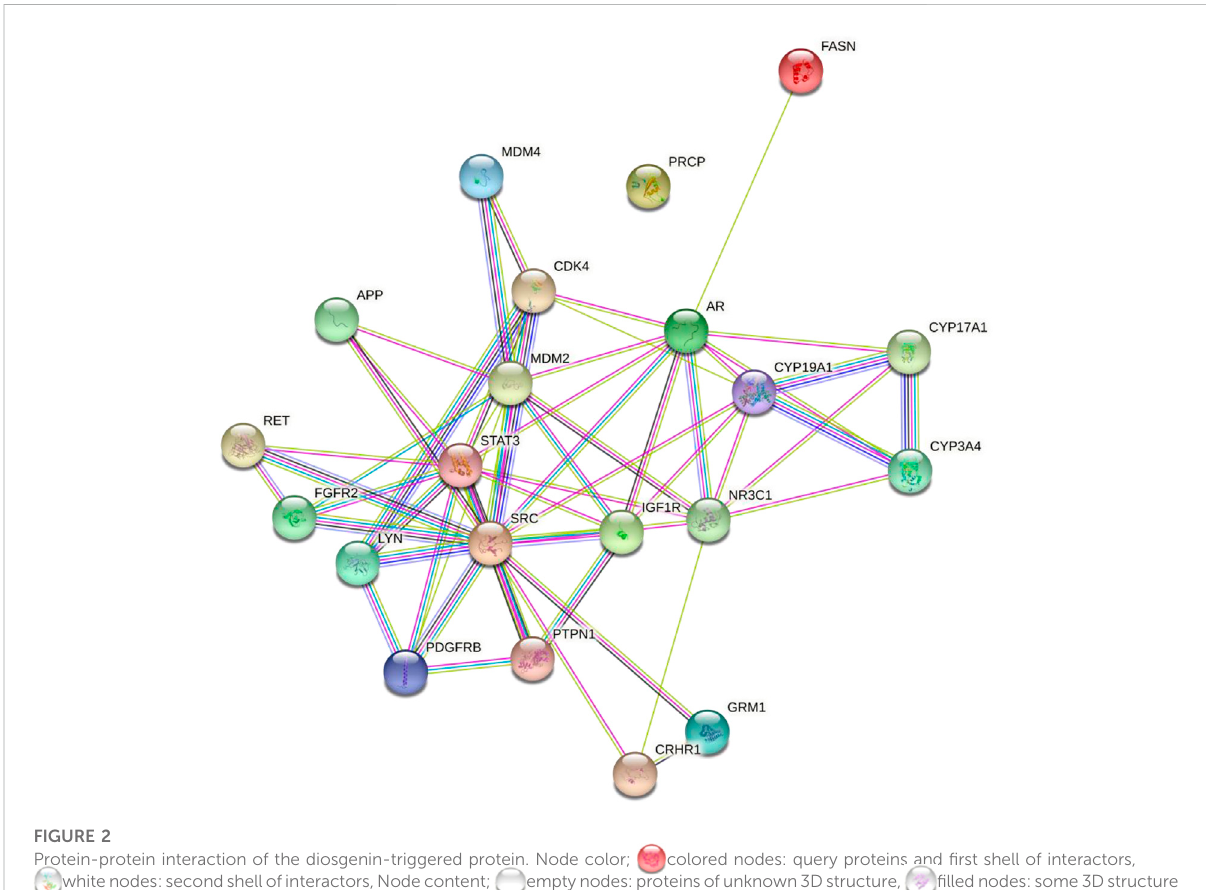
FIGURE 2 Protein-protein interaction of the diosgenin-triggered protein. Node color; colored nodes: query proteins and fi rst shell of interactors, whitenodes:secondshellofinteractors,Nodecontent; emptynodes:proteinsofunknown3Dstructure, fi llednodes:some3Dstructure is known or predicted, Known